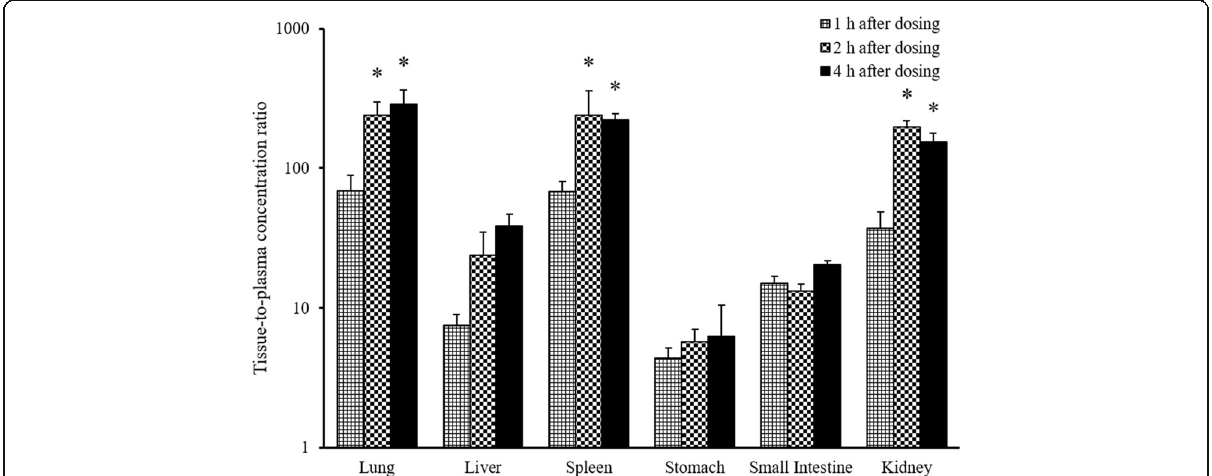
Fig. 4 Mean tissue to plasma concentration ratio of cucurbitacin B after intravenous administration at 0.1mg/kg. The data are represented as mean± SD. * p -value <0.05 compared to the mean tissue-to-plasma concentration ratio at 1h after cucurbitacin B